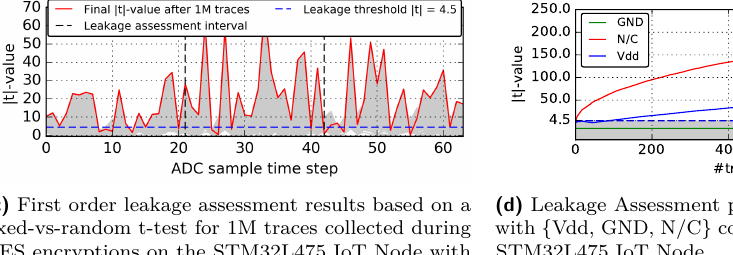
Figure 19: Results of Leakage Assessments on STM32L475 IoT Node for mbedTLS AES.